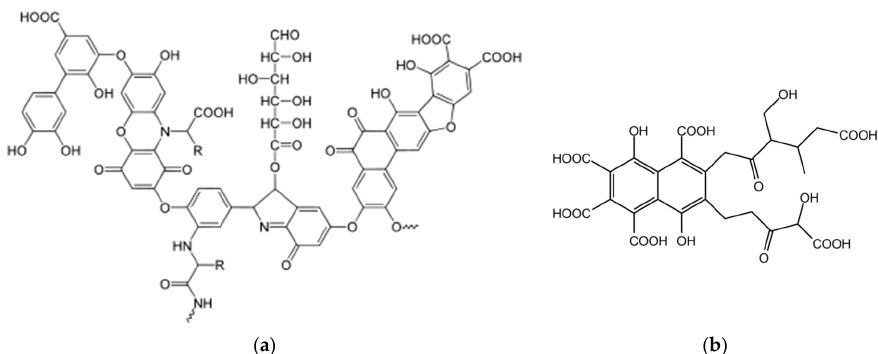
Figure 2. The hypothetical model structure for ( a ) humic acid and ( b ) fulvic acid.